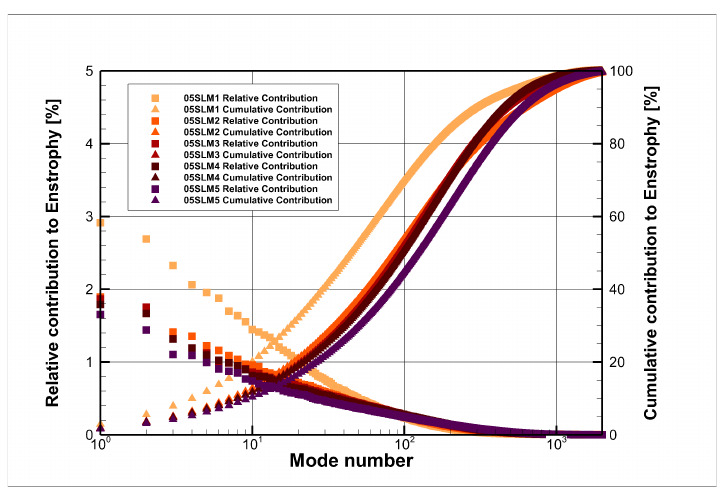
Fig. 4. The relative contribution of the POD modes to the total vorticity for the SBLM1-SBLM5 cases with a reference spire distance D4. The abscissa represents the mode number. Left coordinate represents the relative contribution, right coordinate represents the cumulative contribution.